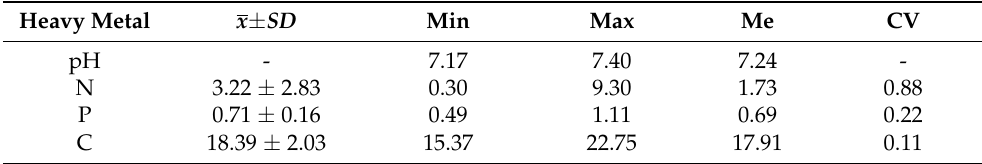
Table 7. Content of N, P, C, and pH in the sediments of Lake Bukwałd (g · kg − 1 of dry matter). Heavy